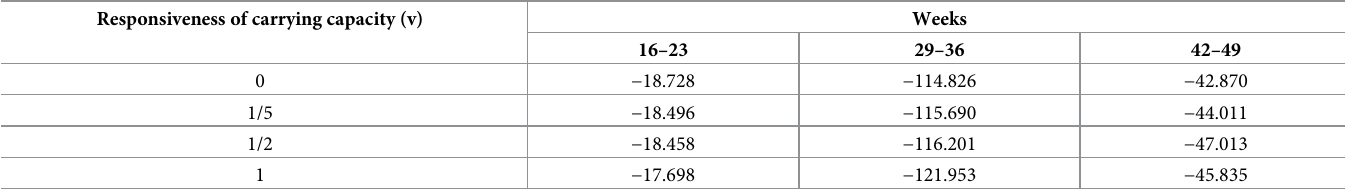
Table 3. Mean log-likelihoods of three specific periods during the simulated term of validation. Responsiveness of carrying capacity